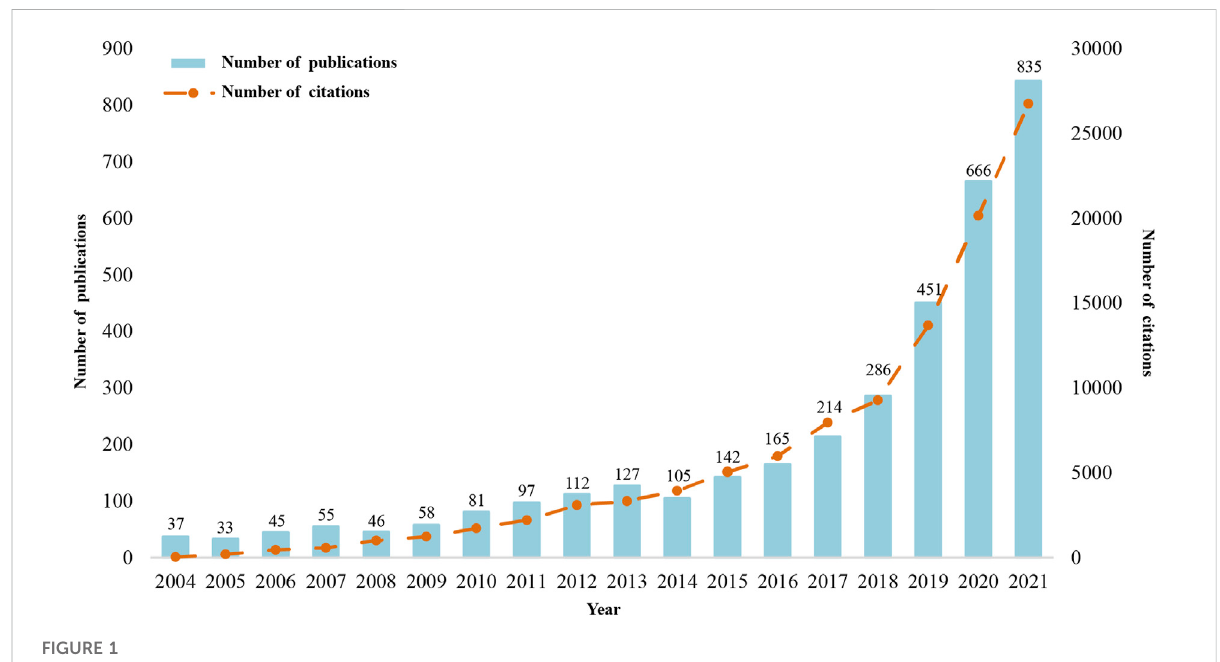
FIGURE 1 Annual number of publications and